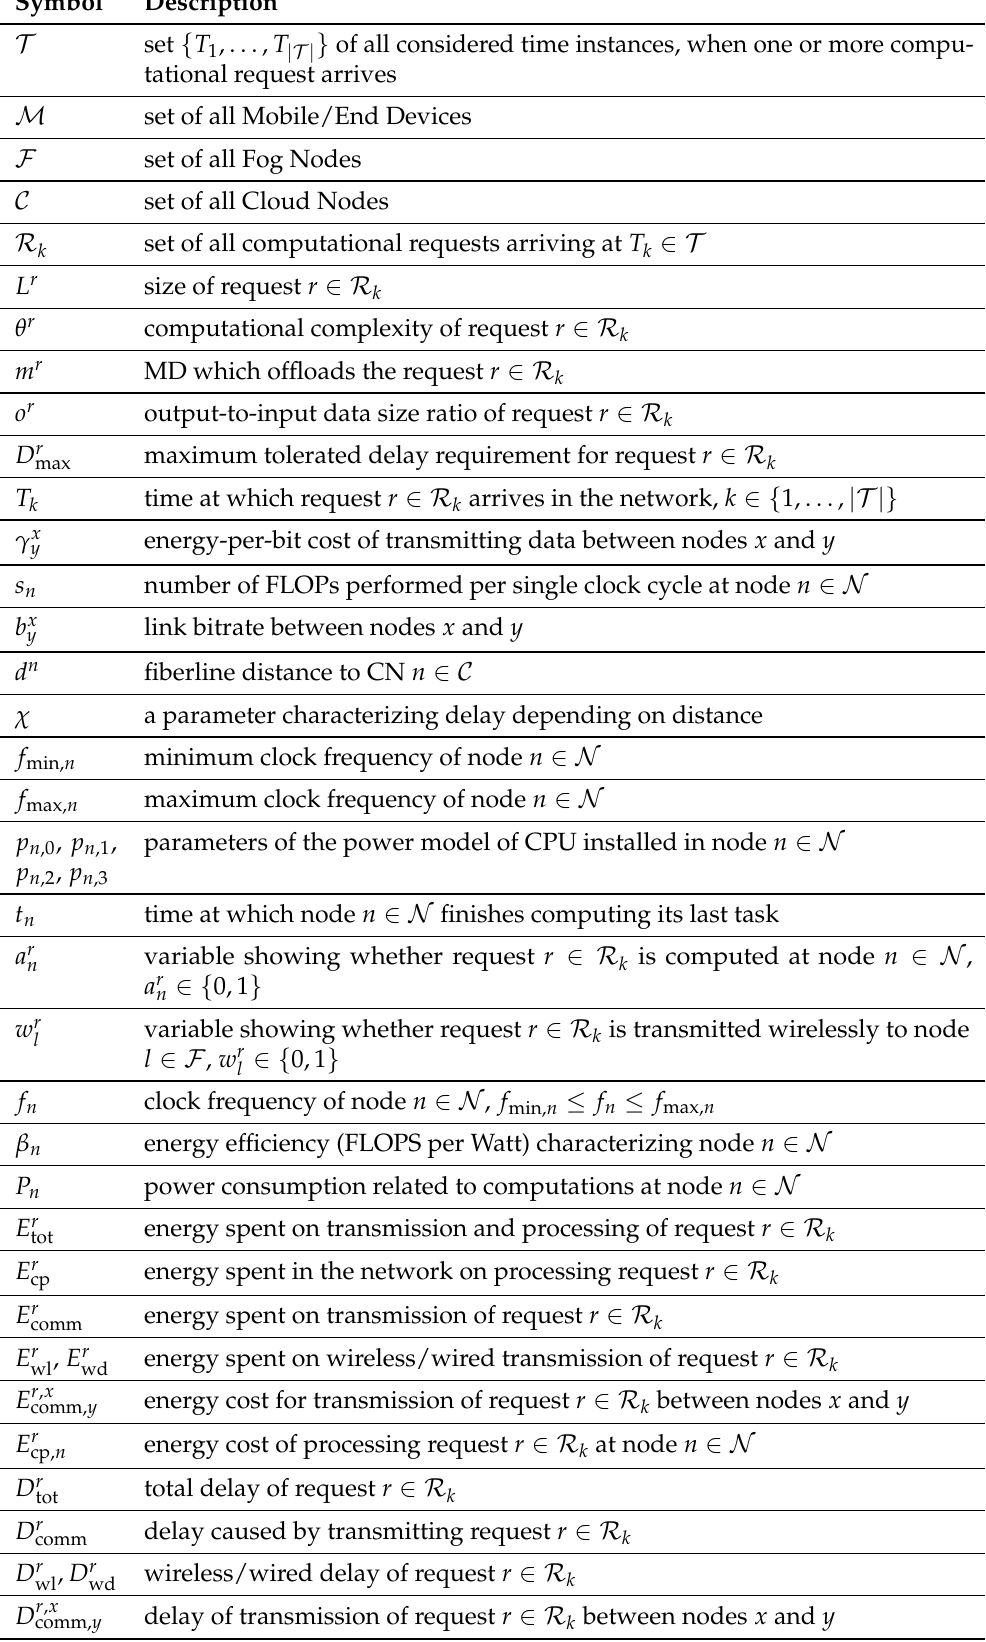
Table 2. The notation used for modeling the network and defining the optimization